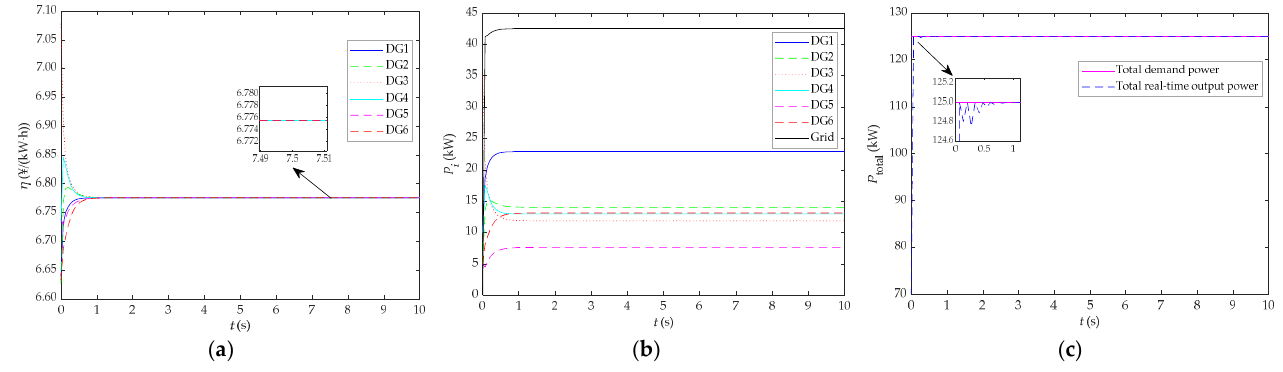
Figure 5. The change curves of variables of the system before algorithm improvement: ( a ) change curves of each DG’s ICR; ( b ) change curves of each DG’s active output and grid output power; ( c ) change curves of the cumulative sum of each DG’s active output and grid output power as well as total demand power.